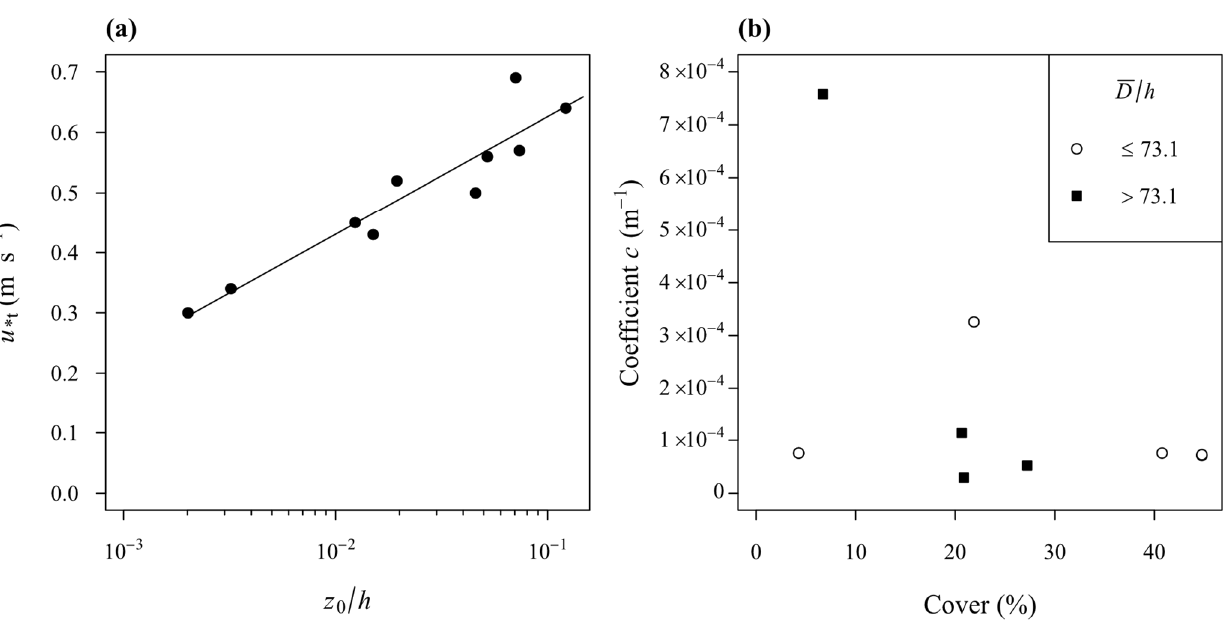
Figure 6. Relationship between u ∗ t and z 0 / h ( a ), and coefficient c and cover with different values of D / h ( b ). In ( b ), the points were divided into high and low categories based on the average of D / h .